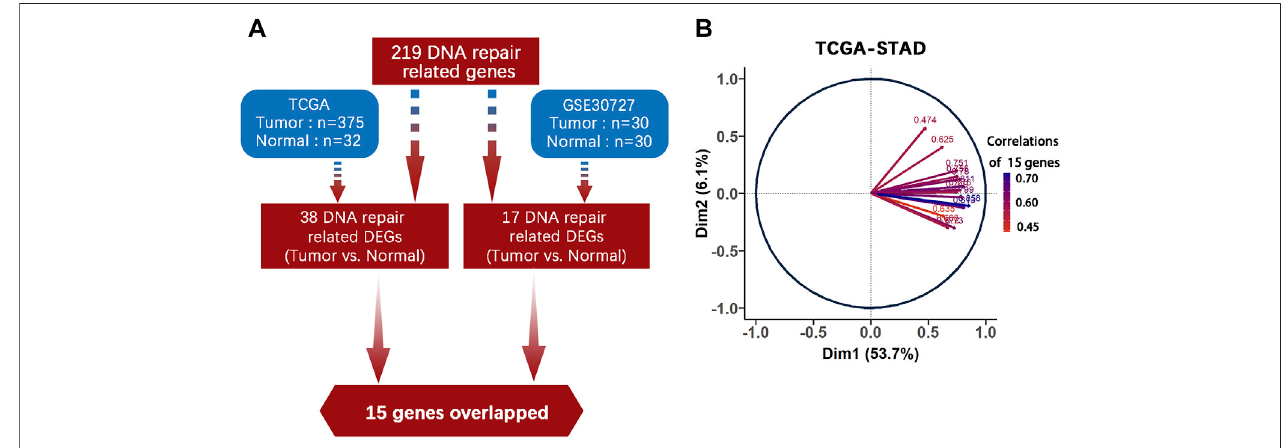
FIGURE 1 | DNA repair genes and construction of the DRGS scoring system. (A) Identi fi cation of 15 common genes among the 219 DNA repair genes that are differentially expressed in both TCGA-STAD (Tumor n = 375, Normal n = 32) and GSE30727 (Tumor n = 30, Normal n = 30); (B) PCA analysis was used as a dimensionality reduction method to obtain the 1st dimension correlation coef fi cients of the 15 repair genes. DEGs: Differentially expressed genes.